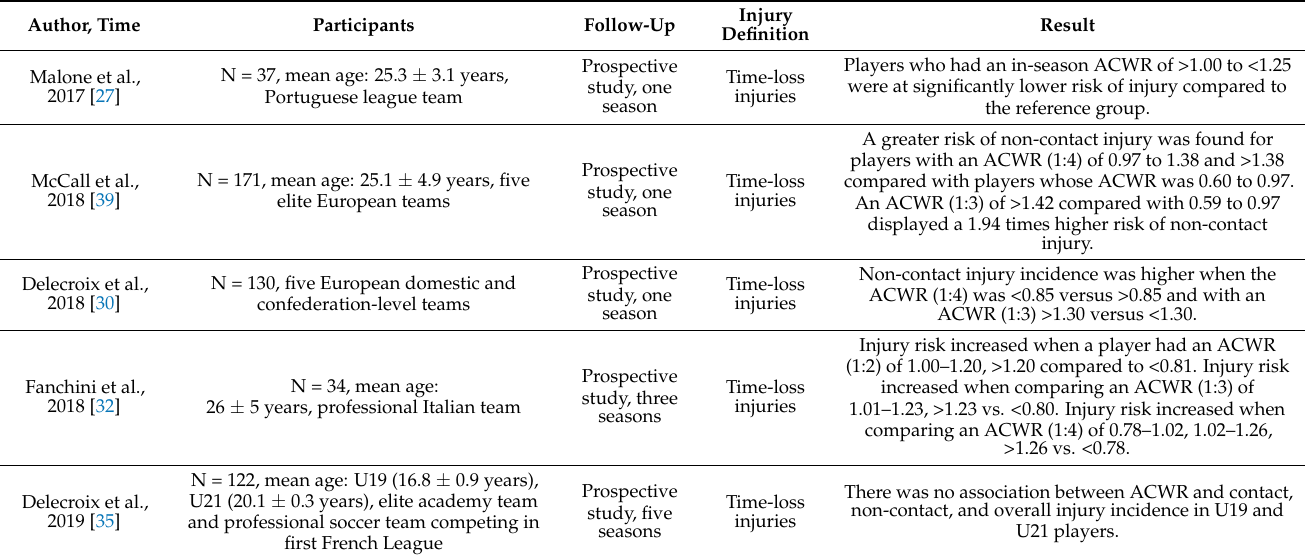
Table 4. The relationship between ACWR for s-RPE and injury risk in the research